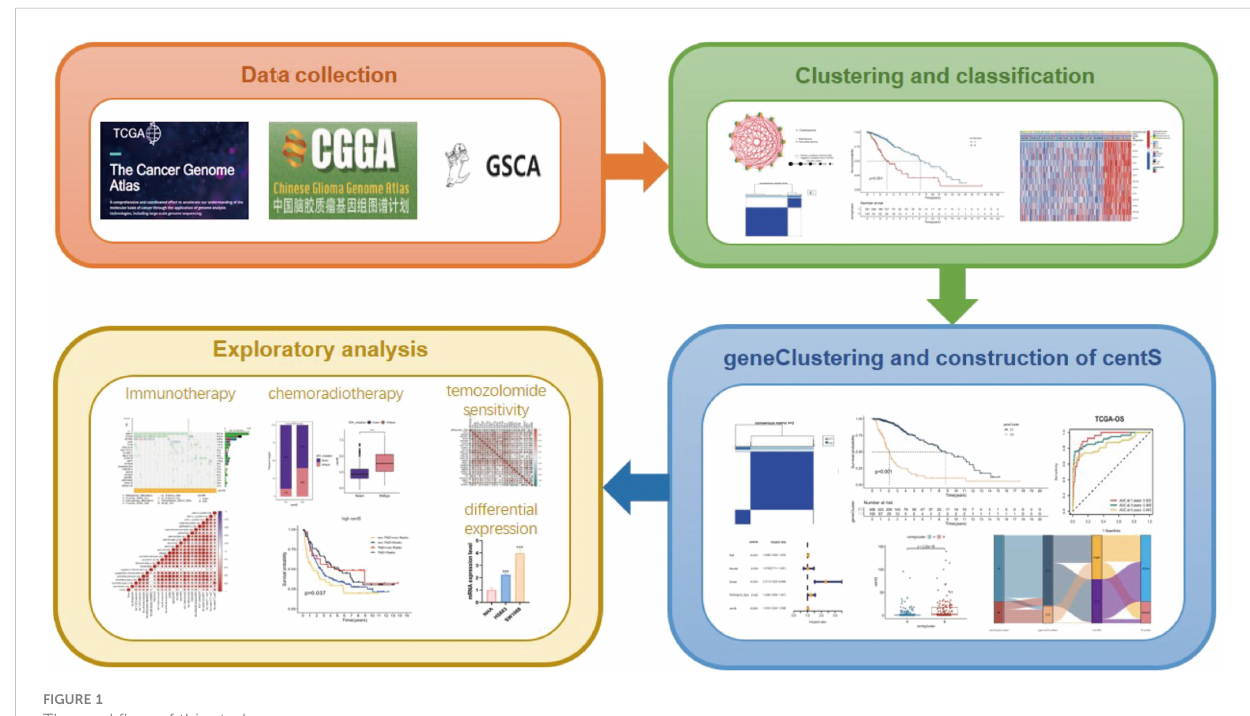
FIGURE 1 The work fl ow of this